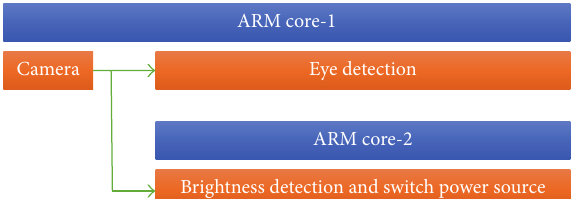
Figure 11: System architecture.